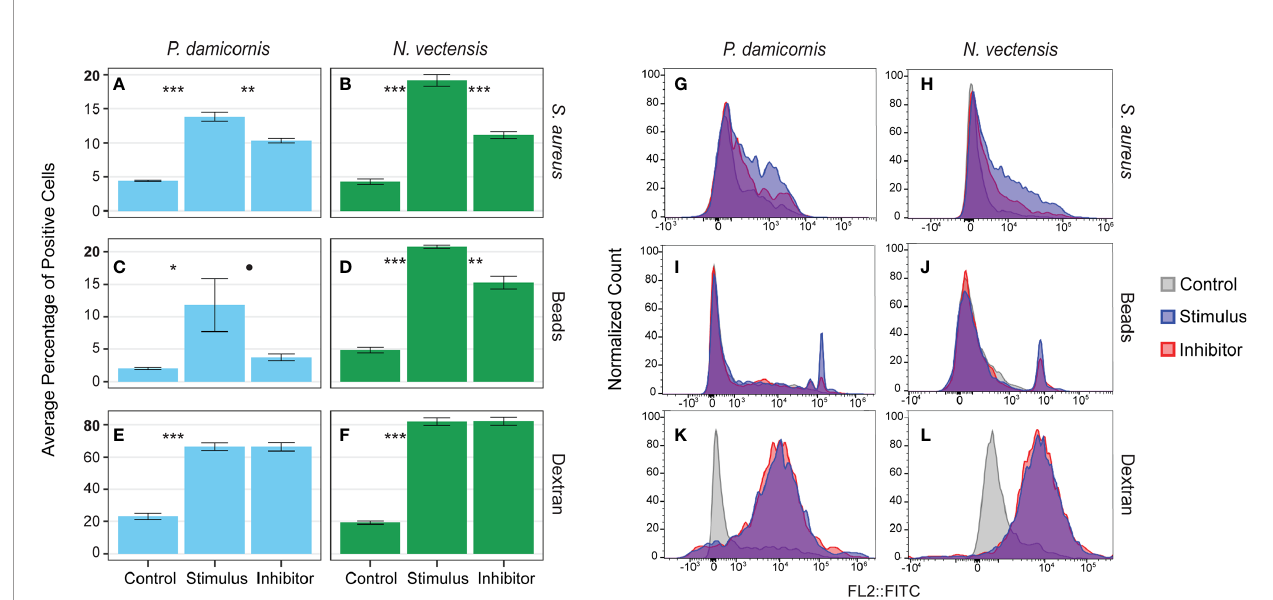
FIGURE 4 | Phagocytosis is a distinct process from pinocytosis and is reliant on actin fi lament movement. (A, C, E) show the percentage of P. damicornis cells positive for each assay while (B, D, F) show N. vectensis . Error bars are representative of the standard error of the mean. (A, B) Cellular uptake of inactive S. aureus particles is signi fi cantly higher in comparison with unexposed controls (p-value in both species < 0.001). The cytochalasin inhibitor resulted in a statistically signi fi cant reduction of cellular uptake of inactive S. aureus particles ( P. damicornis: 25% reduction, p-value < 0.01; N. vectensis : 42% reduction, p-value < 0.001). (C, D) Similar to the inactive S. aureus particles assay, cellular uptake of green carboxylated beads is signi fi cantly higher in the stimulus group compared to an unexposed control ( P. damicornis p-value < 0.05; N. vectensis p-value < 0.001). The cytochalasin inhibitor resulted in a reduction of cellular uptake of green carboxylated beads, which was signi fi cant in N. vectensis (27% reduction, p-value < 0.01), but only at 90% con fi dence in P. damicornis (68% reduction, p-value = 0.072). (E, F) 66.5% of cells in P. damicornis and 82% of cells in N. vectensis were detectable after treatment of dextran particles, indicating that particle uptake was ubiquitous. The cytochalasin inhibitor did not cause a statistically signi fi cant decrease in dextran uptake, indicating that this process is not facilitated by phagocytosis, but rather pinocytosis. (G – L) FACS data for each assay on a histogram of the single fi lter (FITC). (G – J) In the phagocytic assays, the inhibitor sample shows a similar histogram pro fi le as the stimulus, with a reduction in cells with high levels of fl uorescence. (K, L) The pinocytic assay of dextran exposure shows nearly no difference between the stimulus and inhibitor samples. P-value marks: *p < 0.05, **p < 0.01, ***p <